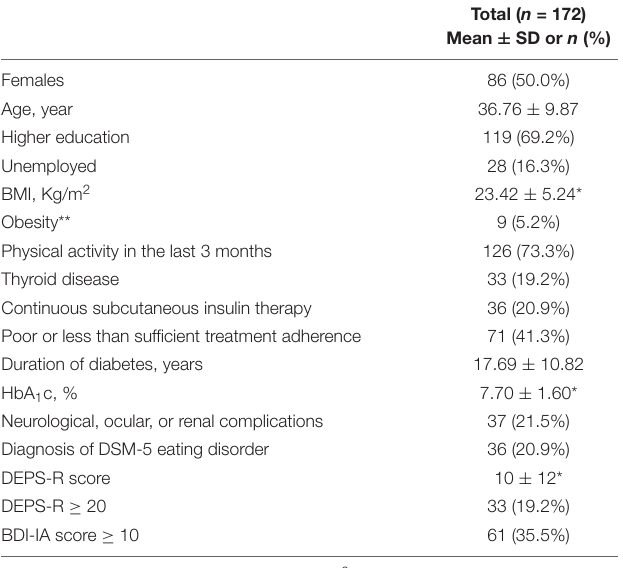
TABLE 1 | Characteristics of participants.